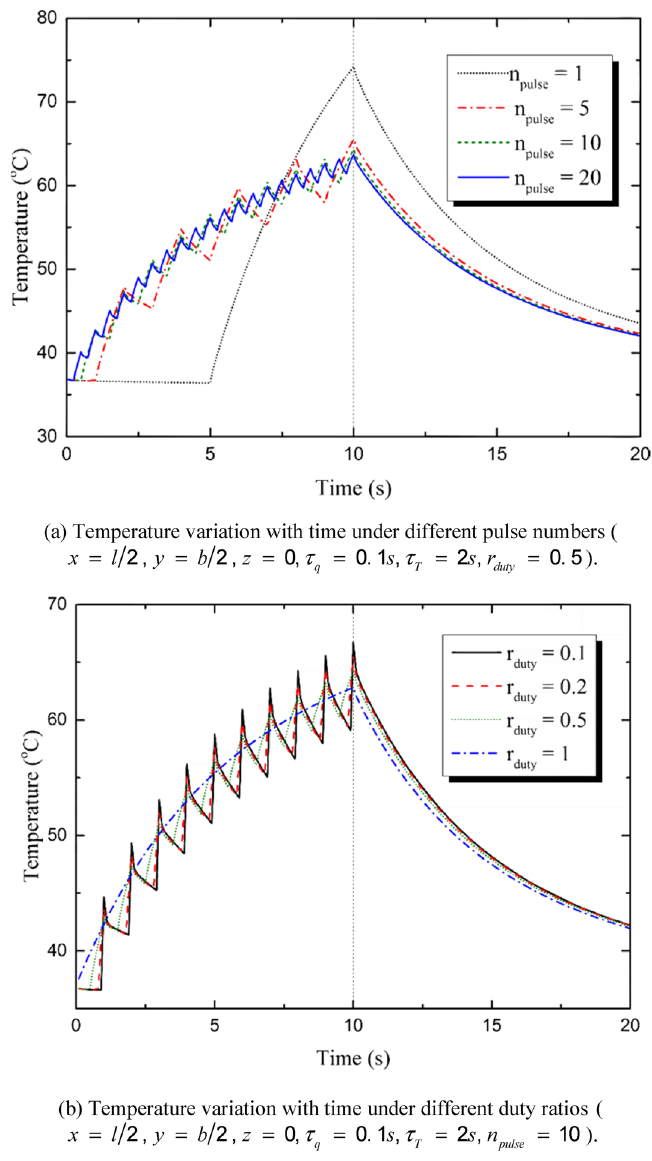
Figure 7. Influences of the laser parameters on the temperature